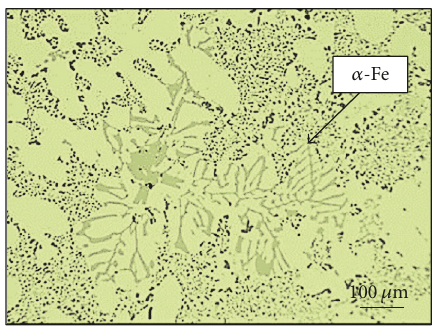
Figure 6: Microstructure of base alloy treated with 80 ppm